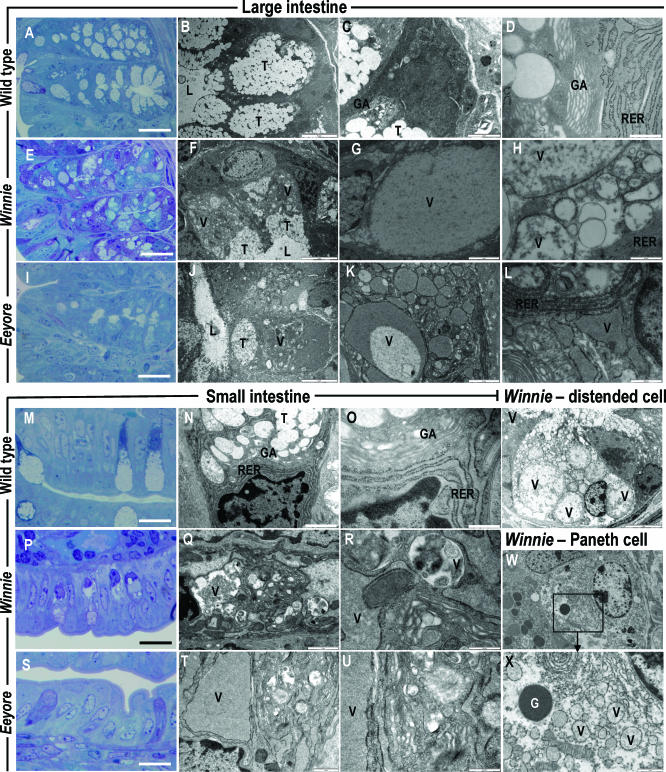
Ultrastructural Evidence of Endoplasmic Reticulum Stress in the Intestinal Epithelium of Mice with Muc2 MutationsSemi-thin sections from resin embedded large intestine of wild-type (A), Winnie (E), and Eeyore (I) mice and small intestine of wild-type (M), Winnie (P), and Eeyore (S) mice stained with toluidine blue. Transmission electron micrographs from the large intestine (B–D, F–H, J–L, and V) and small intestine (N, O, Q, R, T, U, W, and X) of wild-type (B–D, N, and O), Winnie (F–H, Q, R, and V), and Eeyore (J–L, T, and U) mice. Note the reduced size of goblet cell thecae (indicated by a T) containing stored mucin granules and the presence of vacuoles (indicated by a V) surrounded by rough endoplasmic reticulum (RER) in Winnie and Eeyore. Other abbreviations: G, Paneth cell granule; GA, Golgi apparatus; L, lumen. Scale bars 40 μm (A, E, and I), 20 μm (L, O, and R), 5 μm (B, F, J, and U), 2 μm (C, G, K, M, P, S, and V), 1 μm (W), 50 nm (D, H, L, N, Q, and T).